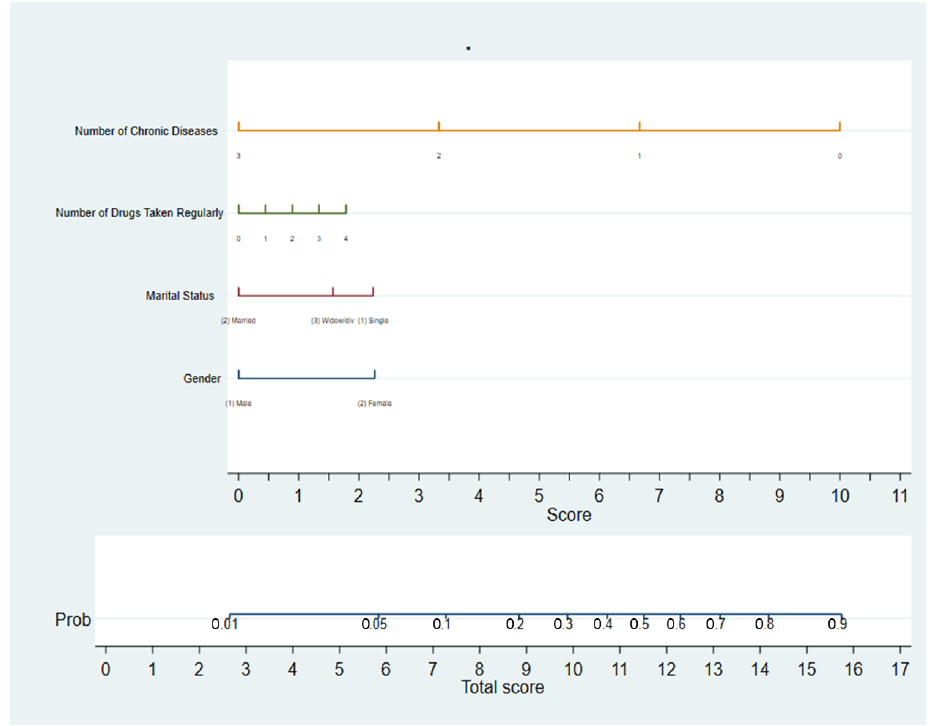
at p ≤ 0.05 . ® : reference value.